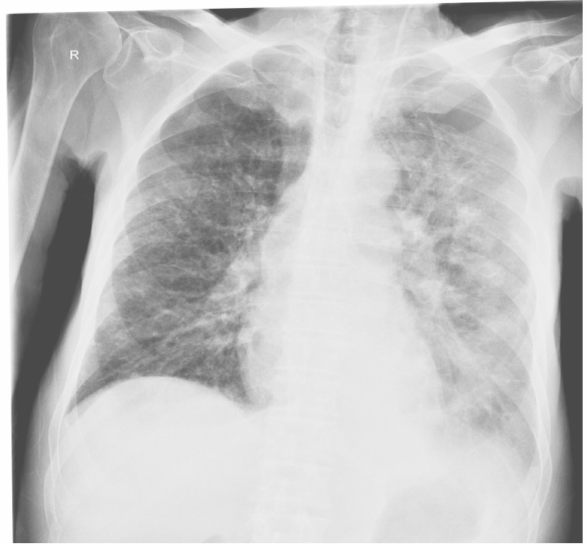
Figure 9. Patient’s X-ray (performed 30 days after hospitalization): bilateral accentuated lung drawing, with alveolar condensation processes, predominantly left lung; opacification of the left cost-diaphragmatic sinus, left apical pulmonary hypertransparency. ‘R’=